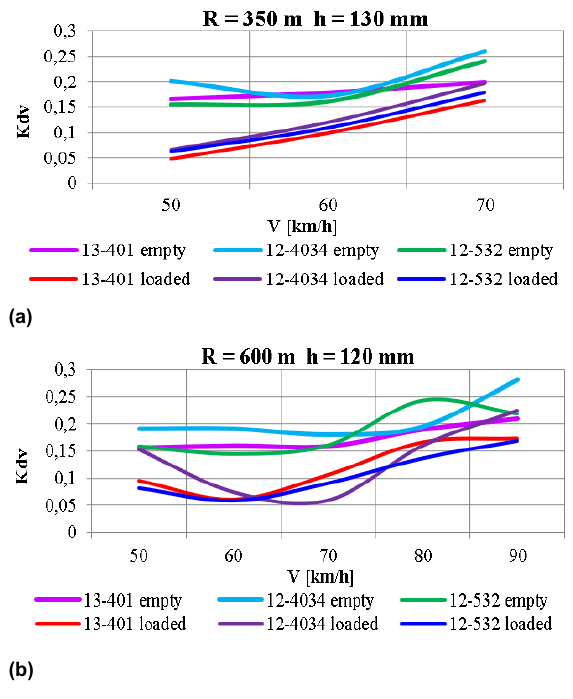
Figure 10. Variation vertical dynamics coefficient central stage of the bogie suspension with the motion speed: (a) R=350 m curve; (b) R=600 m